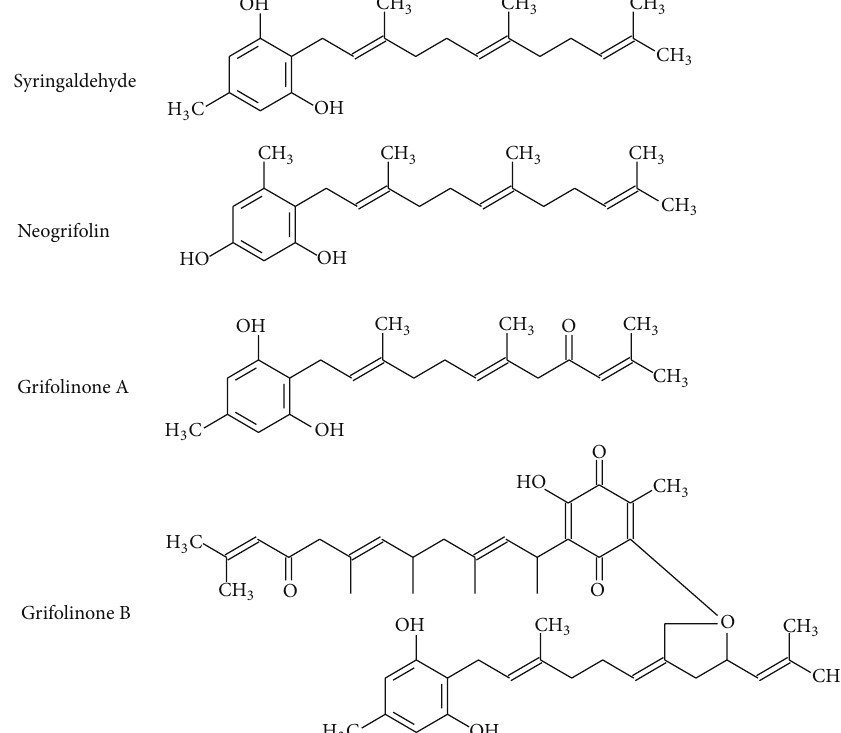
Figure 6: Grifolin and neogrifolins isolated from Albatrellus mushrooms.